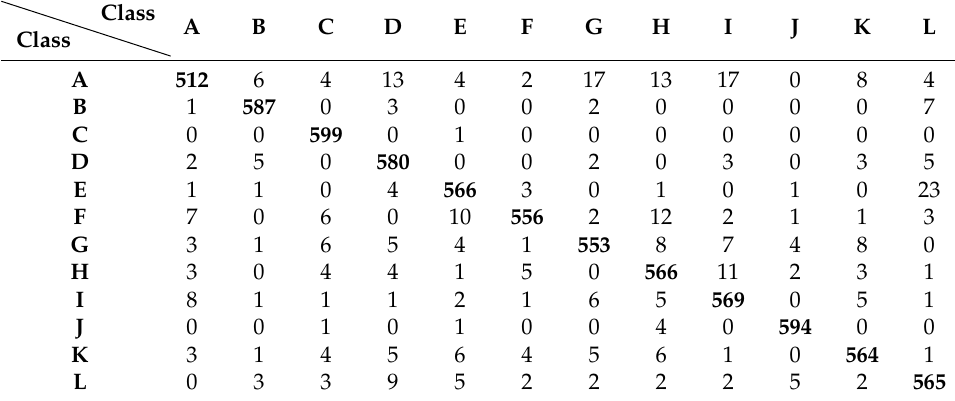
Table 10. Classification results after combination using DS theory for HOG and Elliptical features.